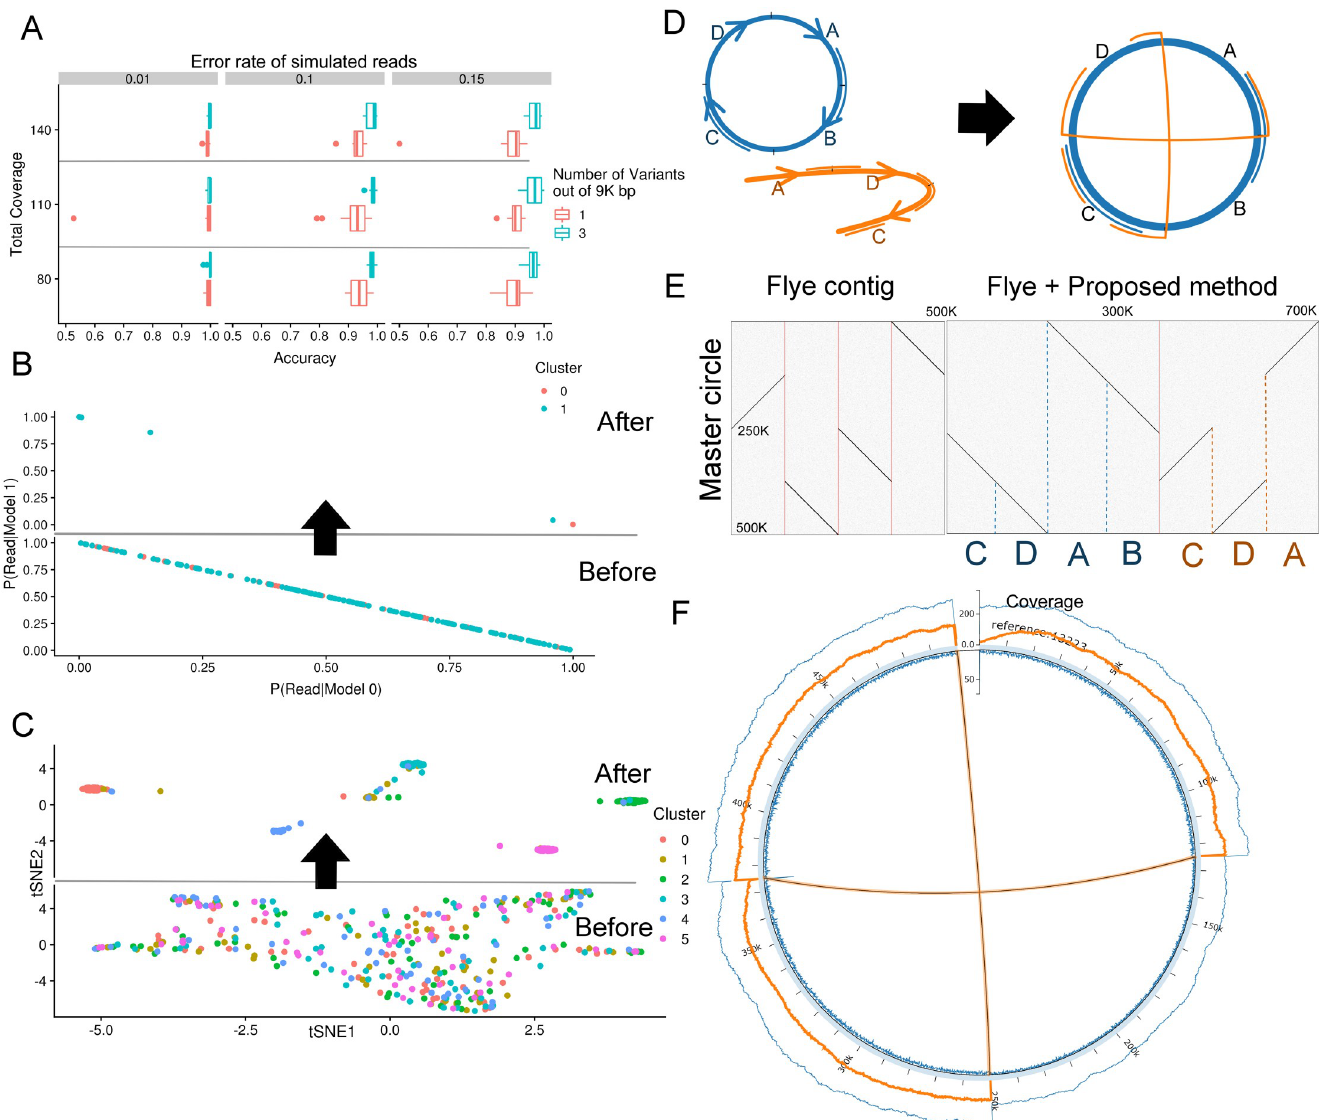
Fig 2. Results using simulated datasets. (A): Accuracy with respect to coverage and number of variant sites in the templates. Each box plot shows the first, second, and third quantiles of these experiments. (B): Plot of Pr { R i j M k }. We sampled 40 reads and 160 reads from the remaining template, respectively; thus, the 200 reads were unevenly distributed in the dataset. The upper figure (“AFTER”) represents Pr { R j M } after clustering, and the lower figure (“BEFORE”) represents the values i k calculated based on assignments initialized randomly. (C): Plot of the posterior probabilities for six templates. We sampled 60 reads from each template. To plot the results in two-dimensional space, we used “RtSNE(https://github.com/jkrijthe/Rtsne).” 30 out of 360 reads were mis-classified. (D): Schematic illustration of two synthetic multipartite structures. The blue circle and orange curve represent a master circle and an alternative linear structure, respectively. (E): Comparison of Flye ’s contigs produced with (right dot plot) or without (left dot plot) our proposed method. We used Gepard [32] to create these dot plots. Red vertical lines represent the boundaries of the contigs. (F): Circos plot of the mock genome. In the figure, from the outside to the inside, the blue line represents the overall coverage of the reference, the orange line represents the coverage of a minor cluster, the thick blue line represents the coordinate axis of the reference, and the number of reads that stop or start alignment at each position can be found along the inner blue line.